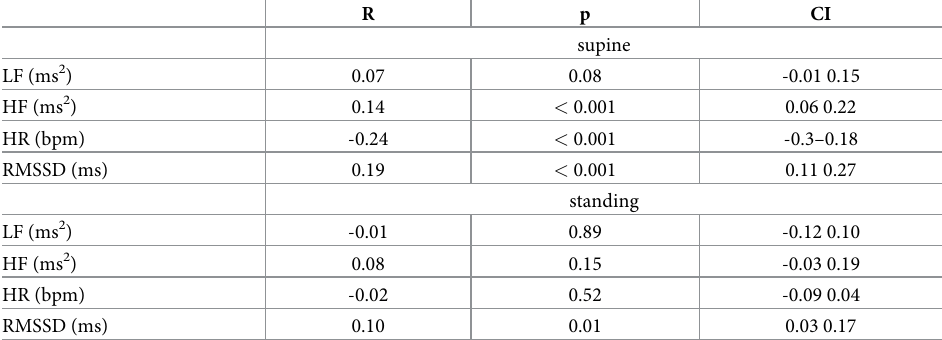
Table 1. Pearson’s correlation coefficient (R), p value, and 95% confidence interval (CI) in the supine and stand- ing positions for HR and HRV parameters against